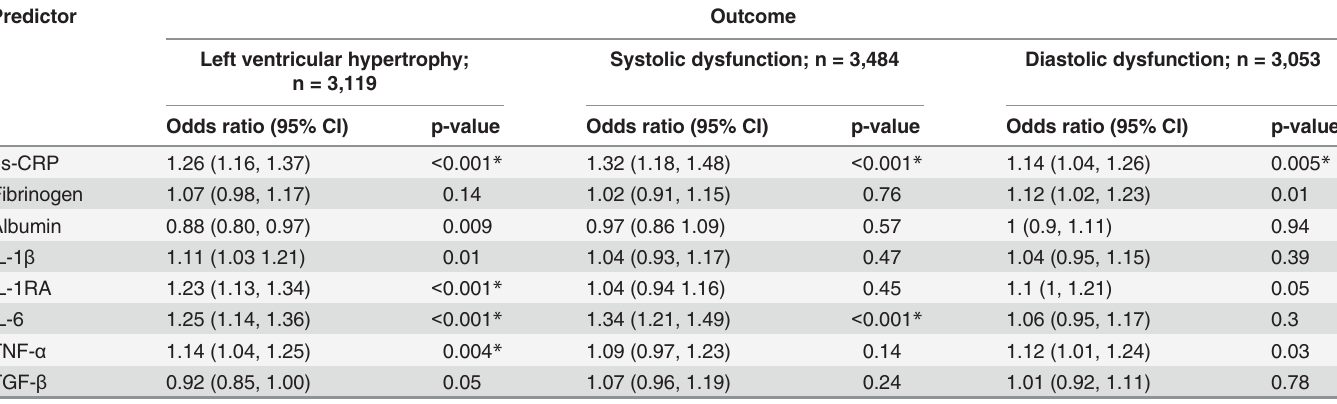
this study shows that inflammation is a potential modulator of cardiac remodeling and func- tion in patients with CKD. lating sarcomeric protein synthesis, enhancing fetal gene expression, altering extracellular ma- trix degradation and triggering apoptosis.[6,18,19] Although most of the circulating cytokines are secreted from activated macrophages and lymphocytes, adipocytes and skeletal muscle are tutively expressed in the myocardium, but are upregulated in response to myocardial injury and may contribute to circulating levels.[22] CRP is a predictor of CVD in the general popula- minuria and high CRP were independently associated with the occurrence of LVH.[25] In a